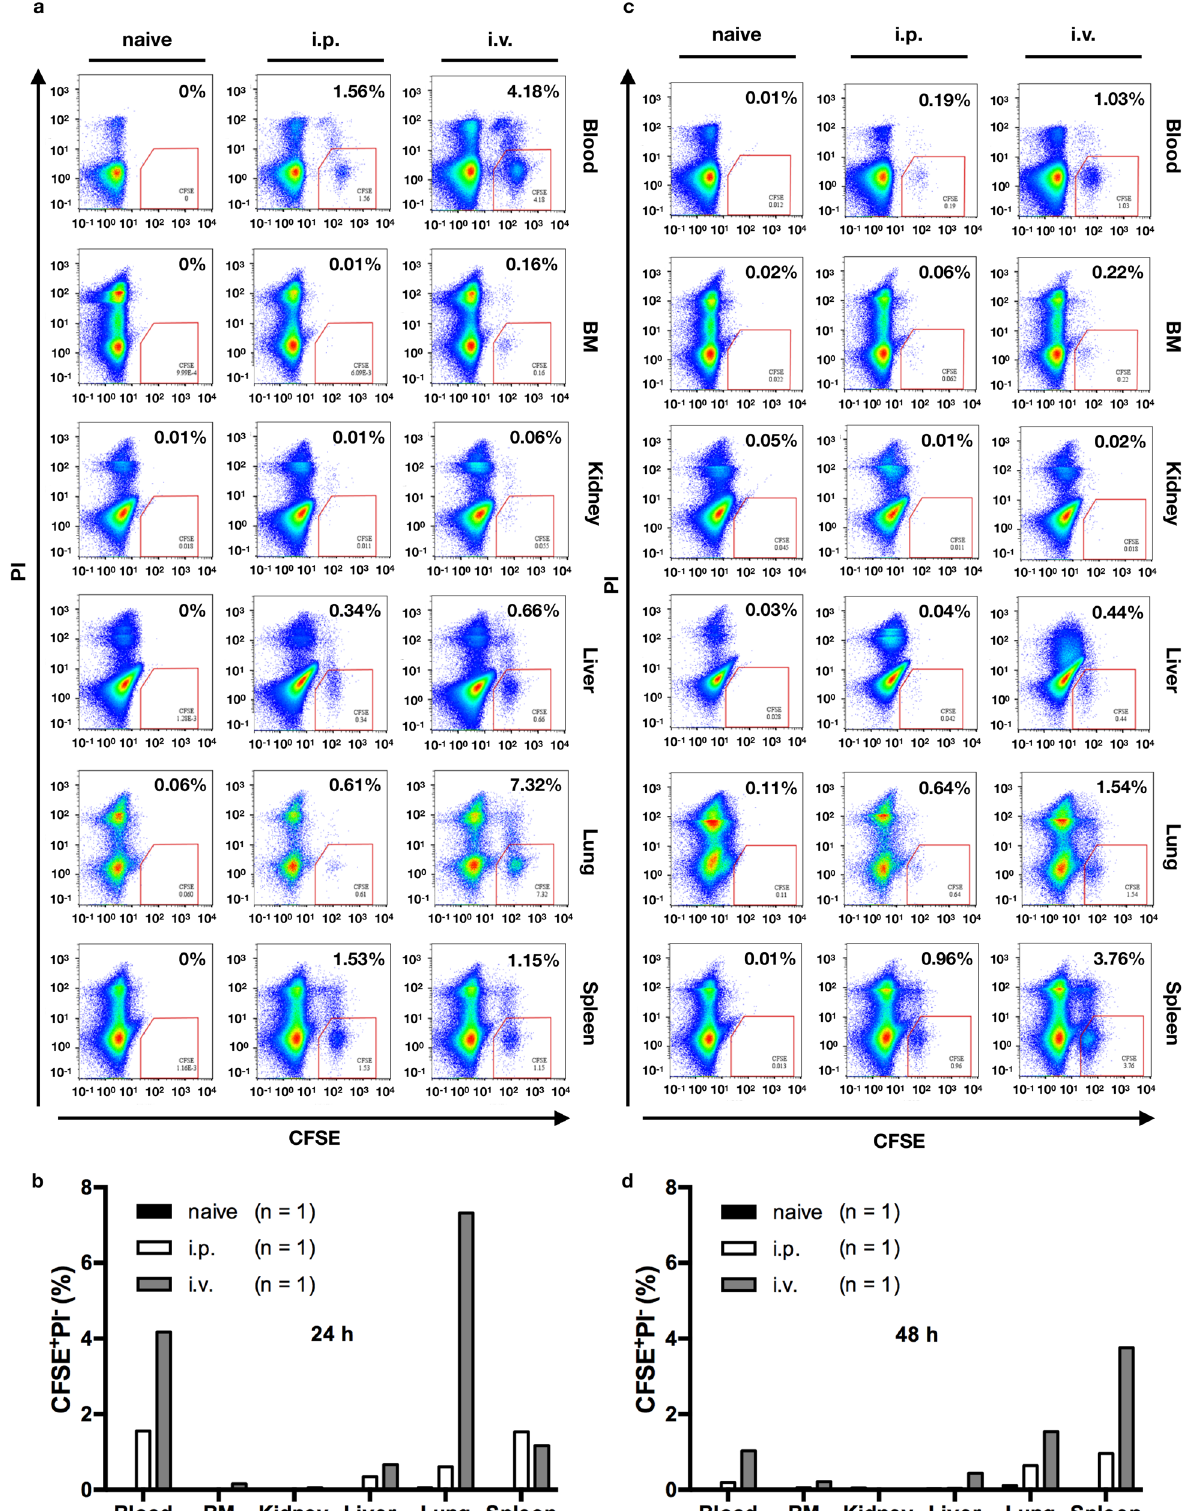
Figure 4. The distribution of engrafted human γ9δ2 T cells in immunodeficient mice. Adult NOG mice (19–20 weeks old, male) were injected with CFSE-labeled human γ9δ2 T cells (derived from one donor; 1.5 × 10 7 cells/mouse) via the peritoneal cavity (i.p.; n = 2) or lateral tail vein (i.v.; n = 2), or left un-injected (naive; n = 2). At 24 ( a , b ) and 48 ( c , d ) hours post-injection, animals were sacrificed for the isolation of lymphocytes from the heart blood, femur bone marrow (BM), kidney, liver, lung, and spleen. For each group, one animal was sacrificed at each time point. The isolated cells were stained with propidium iodide (PI), and the percentage of viable γ9δ2 T cells (CFSE + PI − ) was determined by the flow cytometry analysis. Data were presented as dot plots with PI versus CFSE fluorescence ( a , c ), and the percentage of CFSE + PI − cells in each sample was plotted in bar charts ( b , d ). Black bar ( ■ ): naive; White bar ( □ ): i.p. injection; Gray bar ( ■ ): i.v. injection. Images were created using FlowJo software